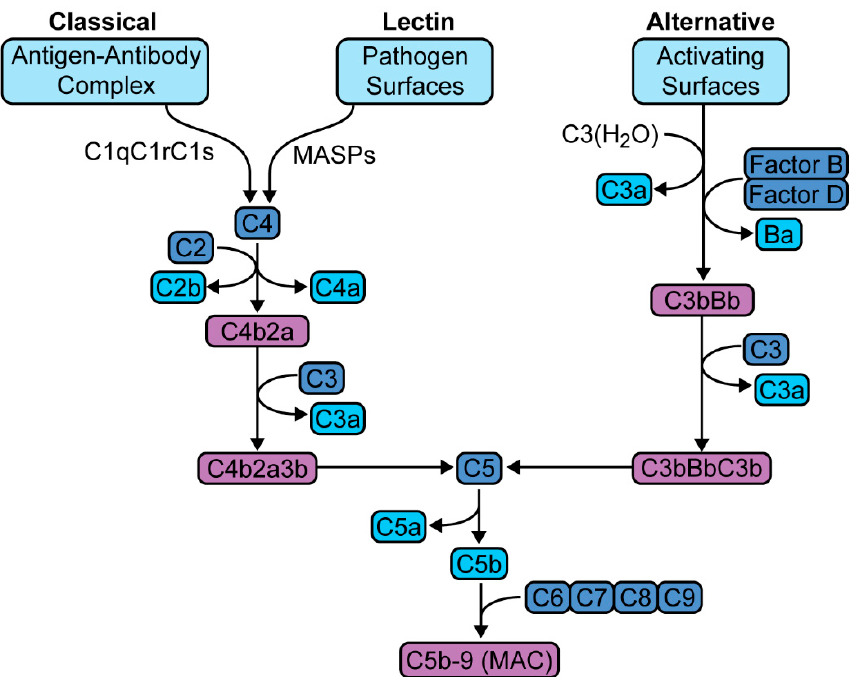
Figure 1. Complement activation pathways. The classical pathway is activated by the binding of antibody-antigen complex with the C1 esterase complex (C1qC1rC1s), which then forms C3 convertase (C4b2a). The lectin pathway is initiated by the binding of mannose-binding lectin with mannose residues on pathogen surfaces, which activates mannose-associated serine proteases (MASPs) to form the same C3 convertase (C4b2a). The alternative pathway is triggered directly by antigen and also through spontaneous autoactivation, leading to the formation of a similar C3 convertase (C3bBb). These C3 convertases hydrolyze C3 to yield the C5 convertases (C4b2a3b and C3bBbC3b, respectively), which culminates in the generation of C5b-9 or MAC (membrane attack complex).